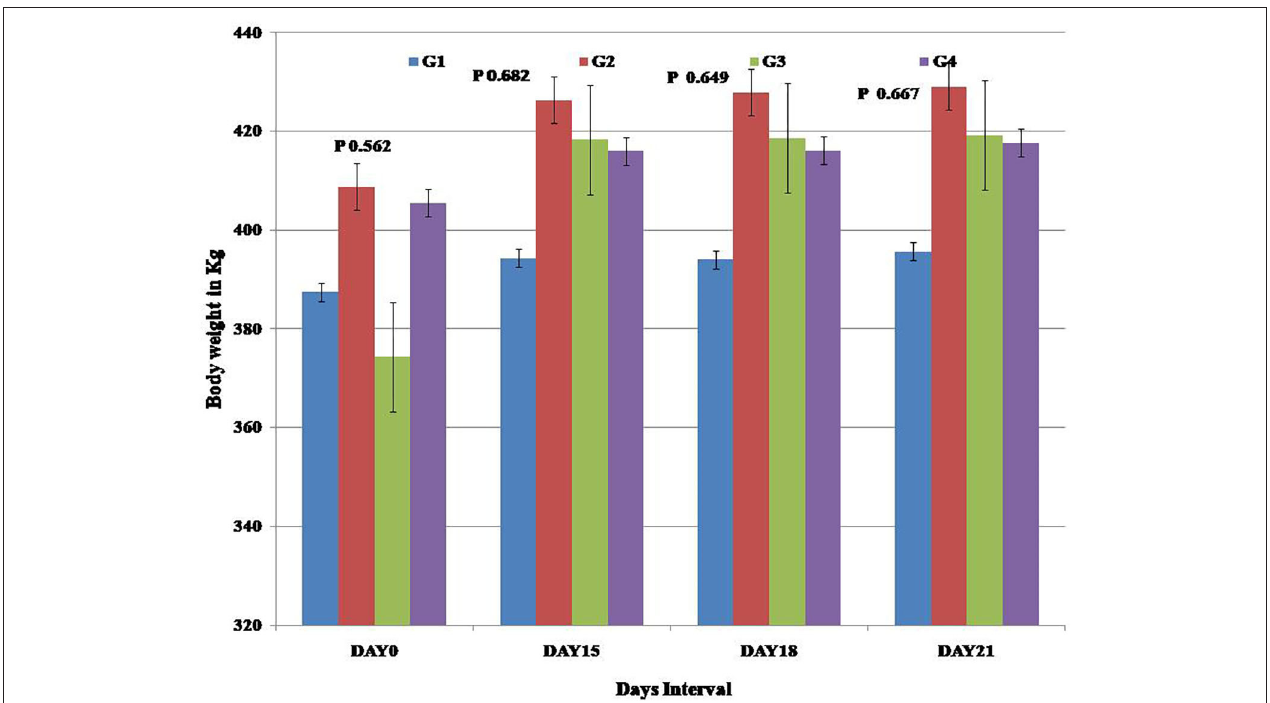
FIGURE 1 | Presentation of body weight (kg) recorded for the horses during the